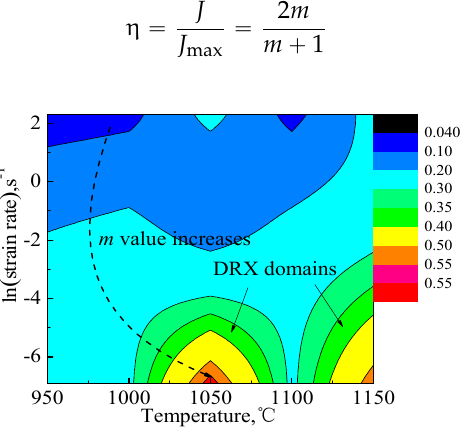
Figure 7. SRS values at the strain of 0.4 for 316LN stainless steel.